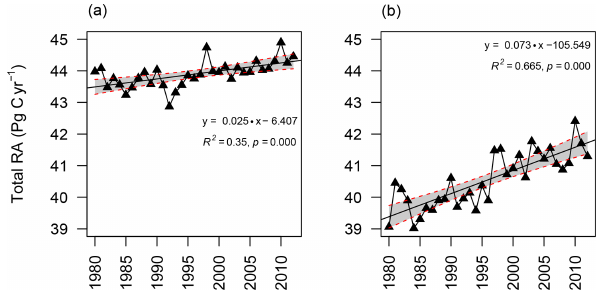
Figure 6. Annual variability in RF-RA (a) and Hashimoto2015-RA (b) from 1980 to 2012. The grey area represents 95% confidence interval.